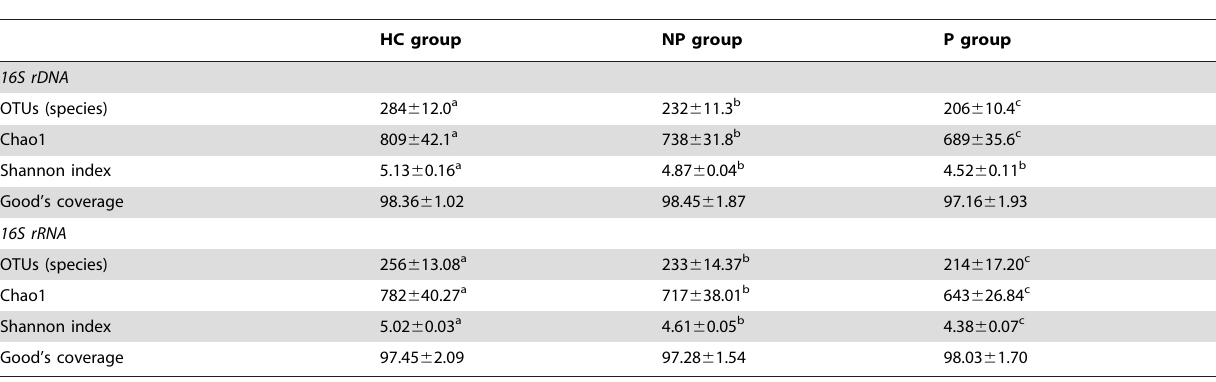
Table 2. Pyrosequencing data